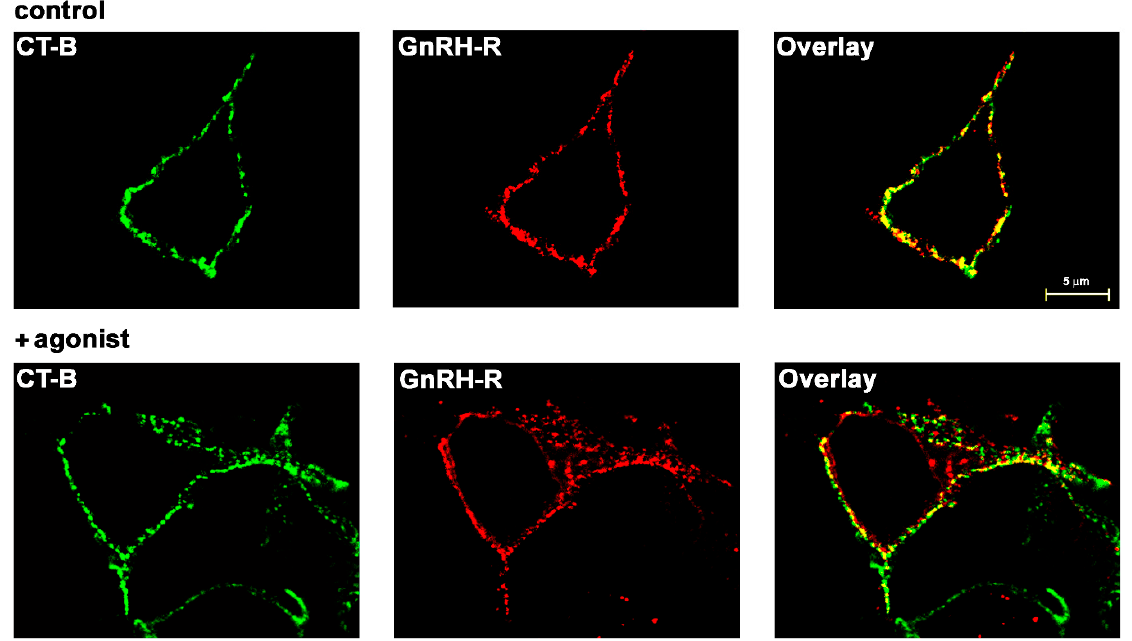
Figure 1. Colocalization of GnRH-R with glycosphingolipid GM 1 -enriched raft-like domain regions of the PM in HEK-293 cells. Live HEK-HAGnRH-R cells were first labeled with the green-fluorescent Alexa Fluor 488 conjugate of CT-B. Cells were then fixed and immunostained for HA-tagged GnRH-R using primary anti-HA monoclonal antibody and then a TRITC-conjugated secondary antibody. Sequentially acquired confocal images show GM 1 -enriched raft-like PM subdomains and a GnRH-R distribution pattern and colocalization in control (upper panels) and agonist treated (D-Trp 6 -GnRH; 1 µ M for 1 h at 37 °C) cells (lower panels). Green color indicates lipid rafts; red is HA-tagged GnRH-R. Merged images show the overlay of two channels; yellow/orange is the overlapping region indicating colocalization of GnRH-R and GM 1 -enriched raft-like domains. Note that PM-localized GnRH-R colocalizes with GM 1 -enriched raft-like PM subdomains in control (unstimulated) and agonist-treated